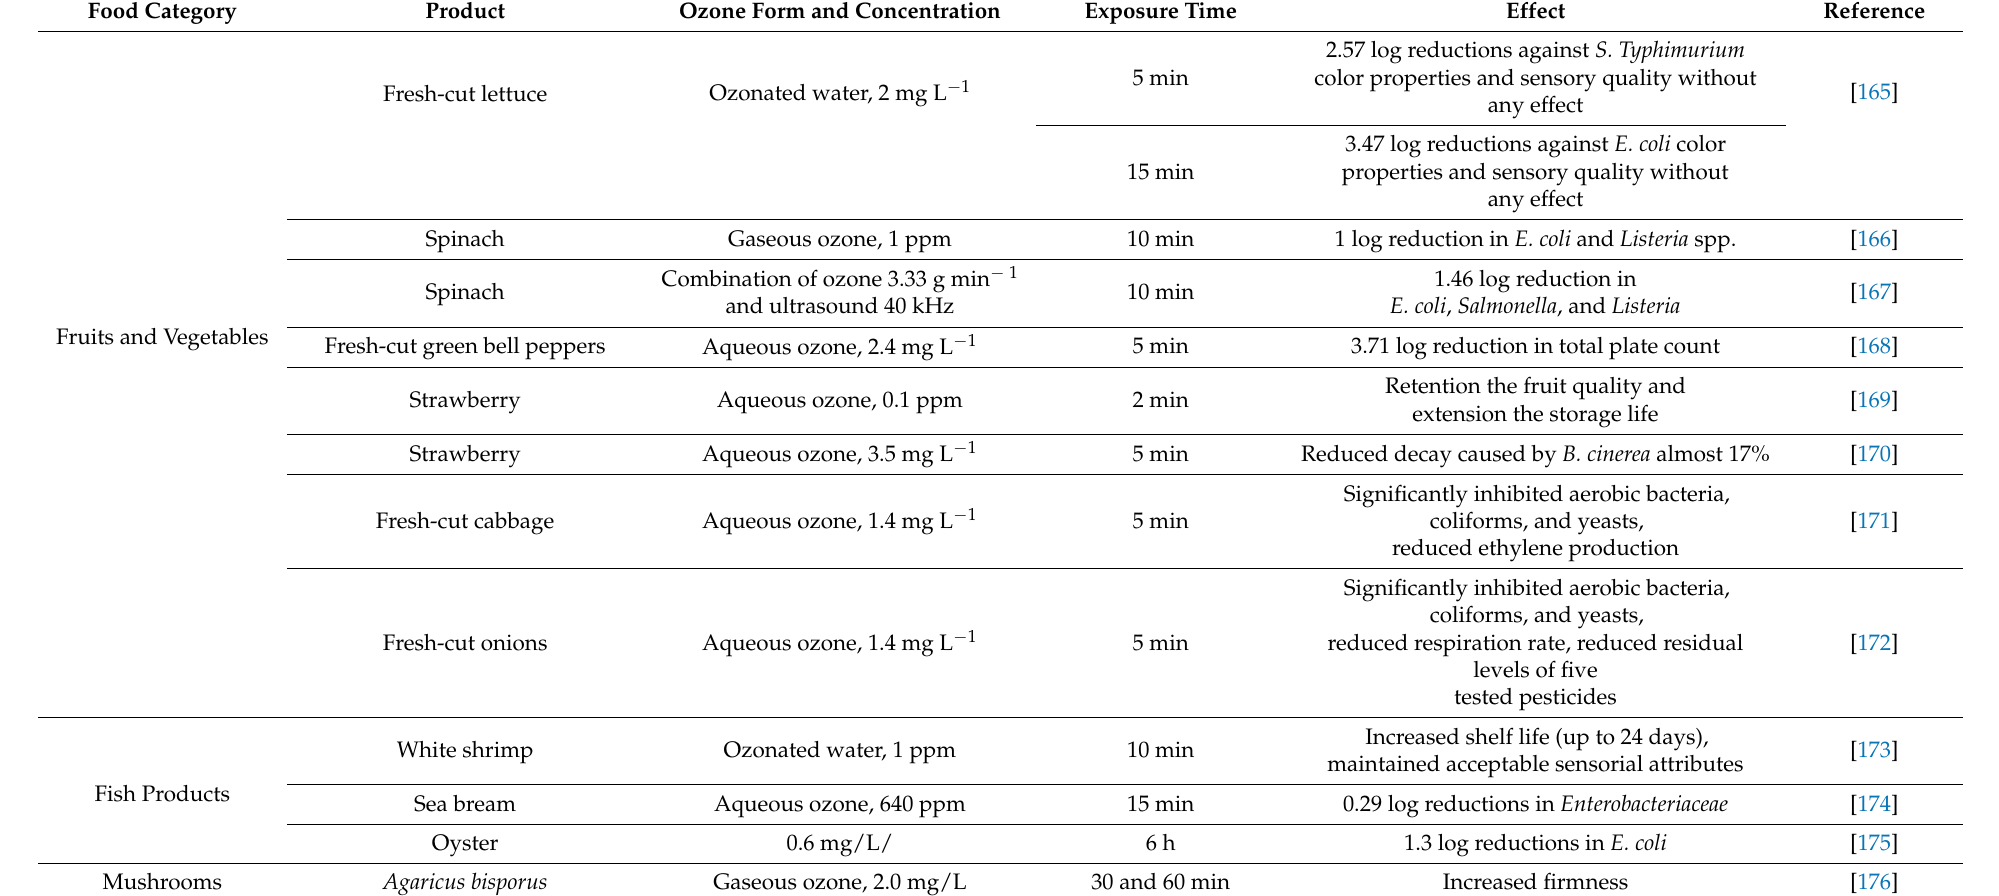
Table 4. Recent studies of applications of ozone in different food